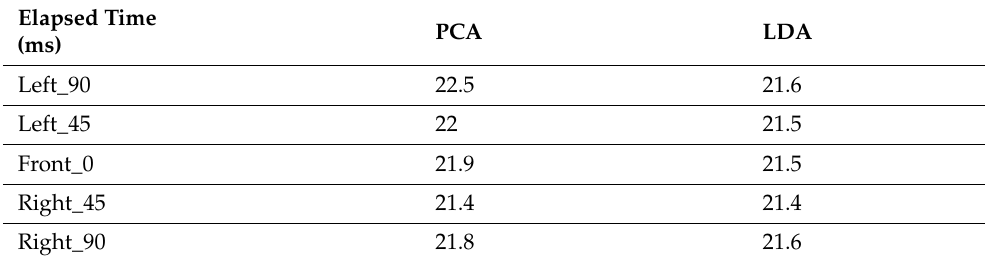
Table 4. Elapsed time to estimate each head pose using PCA and LDA.